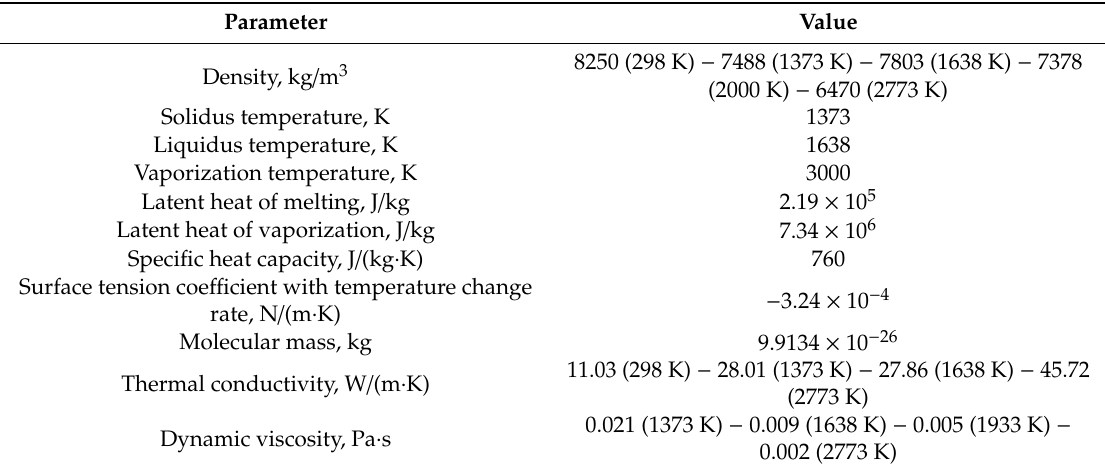
Table 1. Physical parameters of the Inconel 718